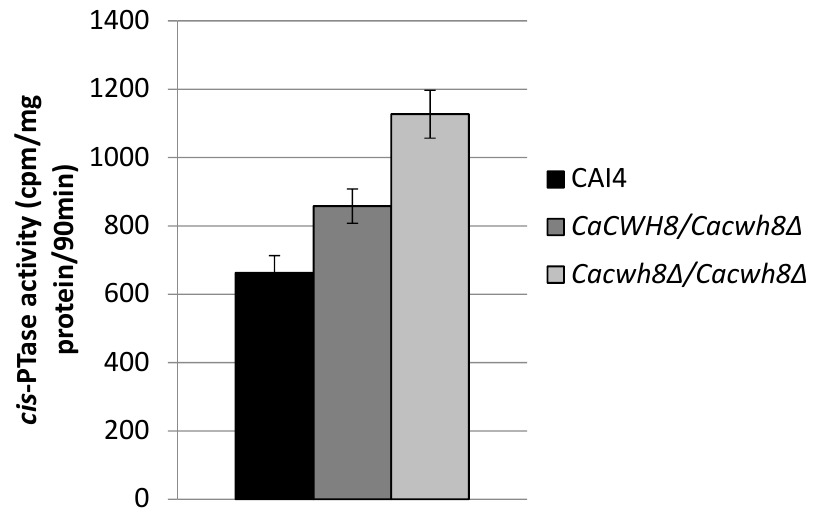
Figure 4. Activity of cis -PTase in the wild type C. albicans strain CAI4 and the CaCWH8 mutants.